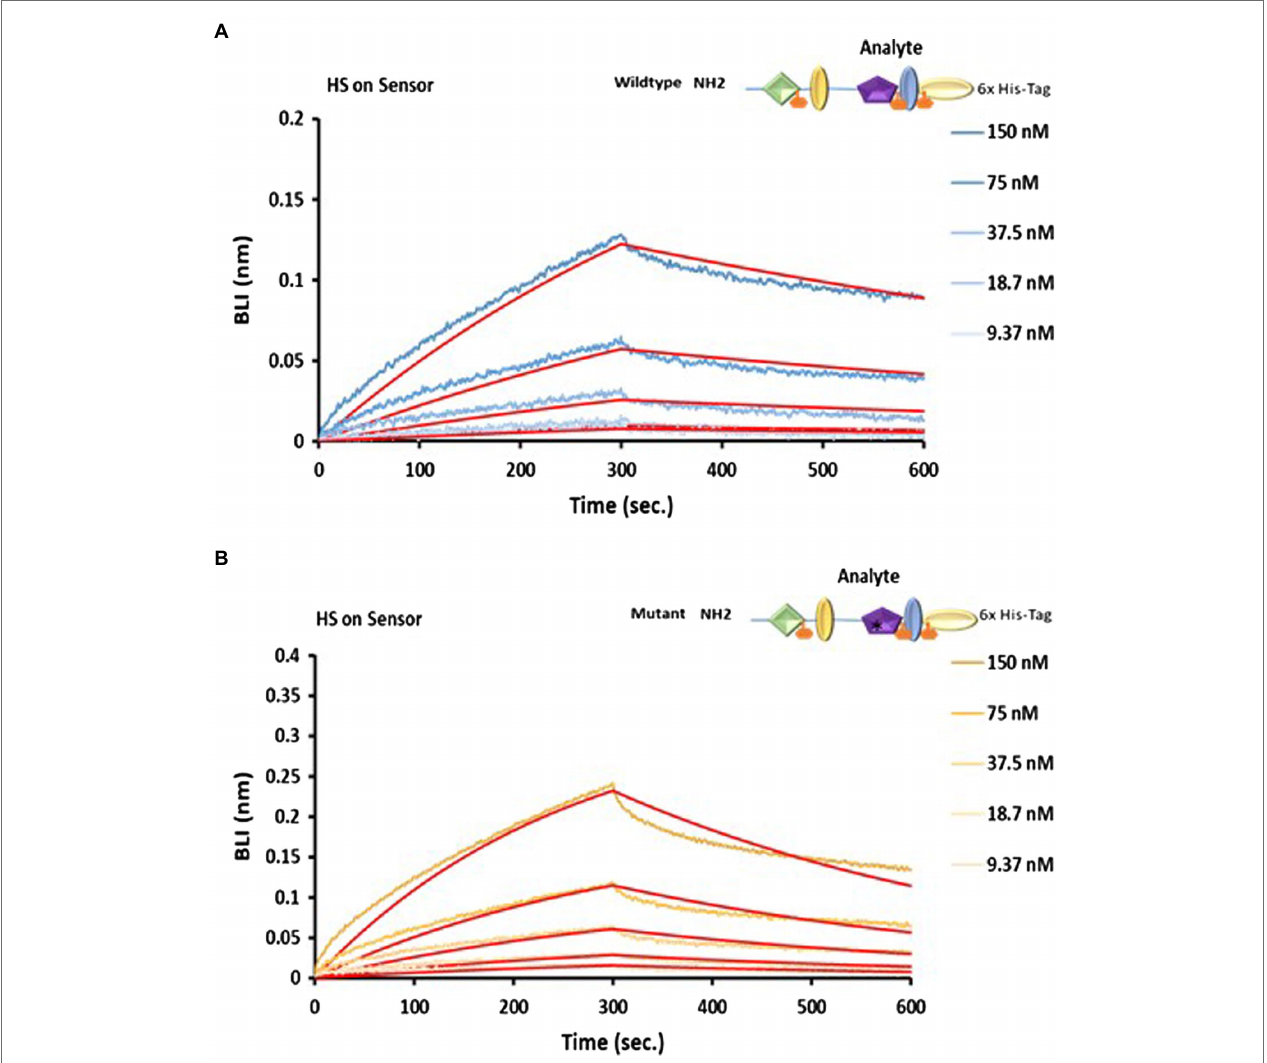
FIGURE 7 | Analysis of LTBP4 N-terminal interaction with fibronectin and HS using BLI. OctetRED sensorgrams showing both (A) the wild type and (B) mutant N-terminal region at a range of concentrations (150–9.37 nm) bind to immobilised heparin. The binding affinity KD was 52.6 nm for the wild type and 53.4 nm for the mutant, determined by fitting to a 1:1 Langmuir binding model (red curves). All experiments were performed in at least duplicate and representative results are